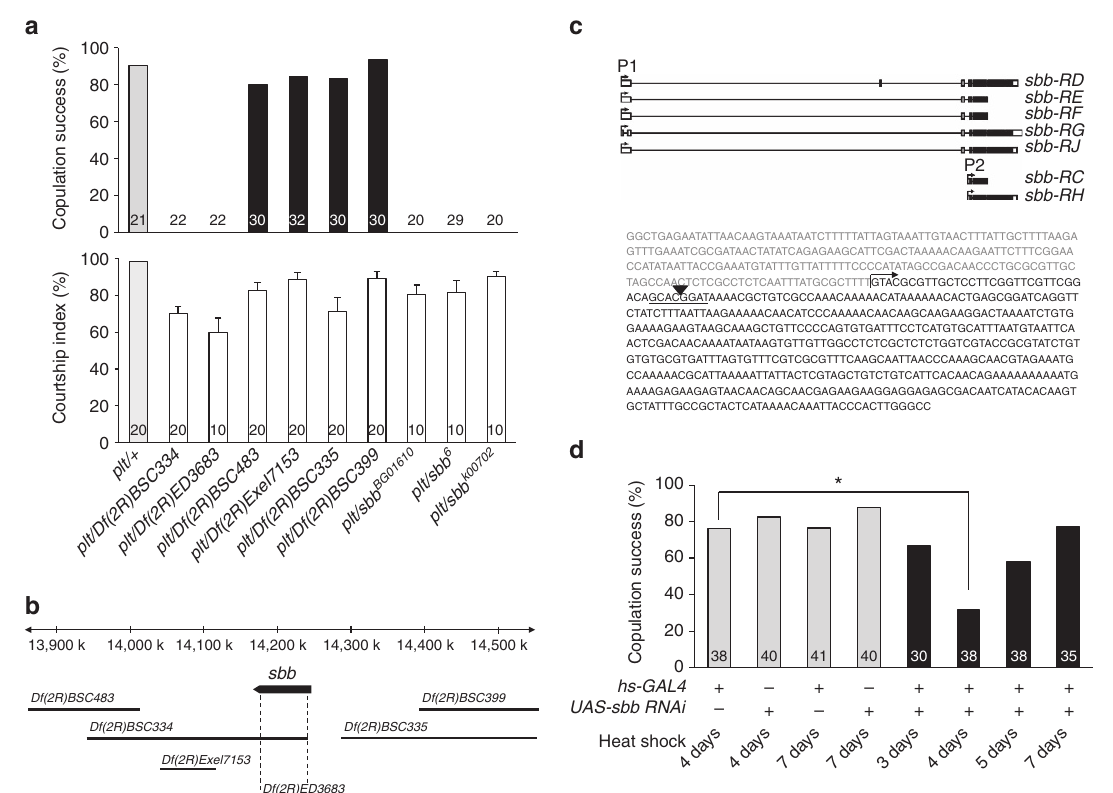
Figure 1 | Mapping the plt mutation. ( a ) Courtship activities (lower panel) and copulation success (upper panel) for the indicated mutant and control flies. In the lower panel of a , the mean ± s.e.m. values are shown. ( b ) Deficiency mapping of the plt mutation onto the genome. The top horizontal bar indicates the physical distance (in kb) relative to the sbb transcription start site. The sbb -transcribed region is indicated with an arrow, the direction of which indicates the direction of transcription. The deleted region for each deficiency chromosome is shown below the arrow (horizontal bars). ( c ) The genomic organization of the sbb gene (upper panel) and the sequence determined by inverse PCR (lower panel). In the upper panel, exons (black boxes: coding regions; open boxes: non-coding regions) and introns (thin horizontal lines) for several transcripts are shown. In the lower panel, the mutagenic P -element insertion site (an inverted triangle), the target sequence of the P -element (underlined) and the transcription start site are indicated. ( d ) Effect on the copulation rate of developmental timing of sbb knockdown. The transgenes carried by tested flies are indicated below each bar ( þ , with the transgene; (cid:2) , without the transgene). In all graphs, the number of flies examined is indicated below each bar. In d , statistical differences are evaluated by the w 2 -test (* P o